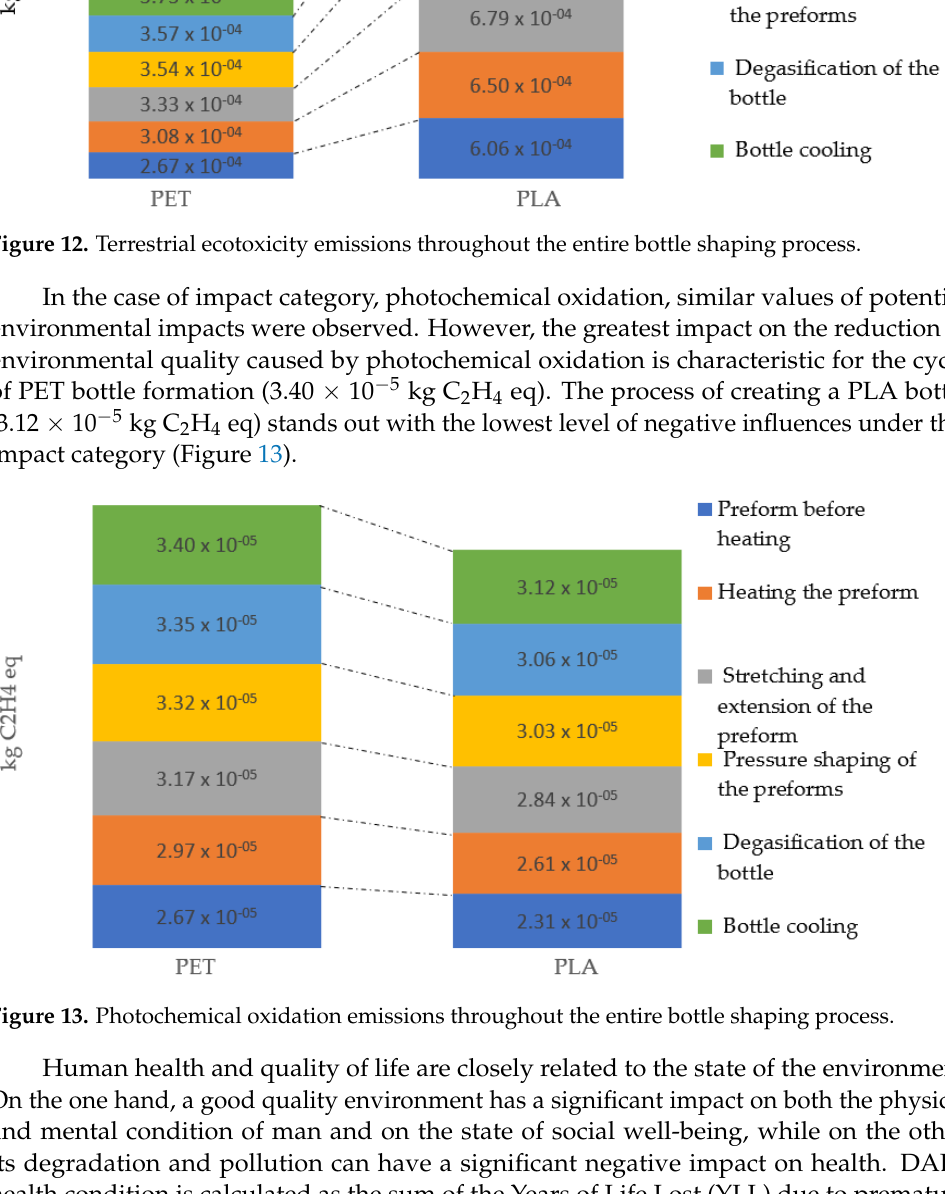
levels <2.5 μm with similar potential impacts on human health were noted for the